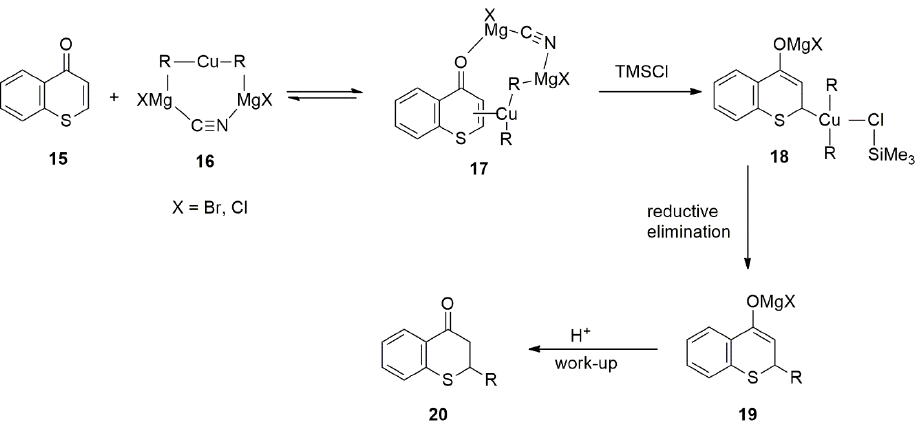
Figure 16. The Role of TMSCl in the Conjugate Addition of Grignard Reagents to Thiochromones .